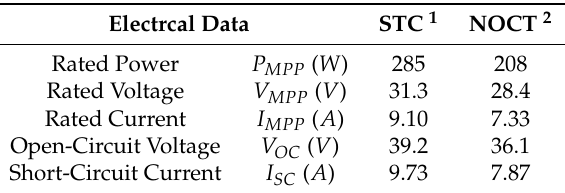
Table 1. PV module electrical